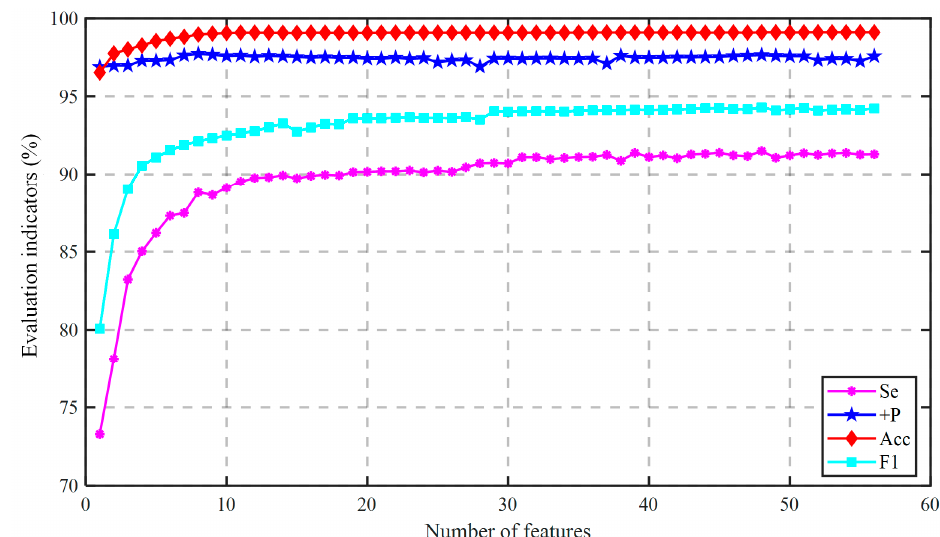
Figure A5. The performance change with the “colsample_bytree”.